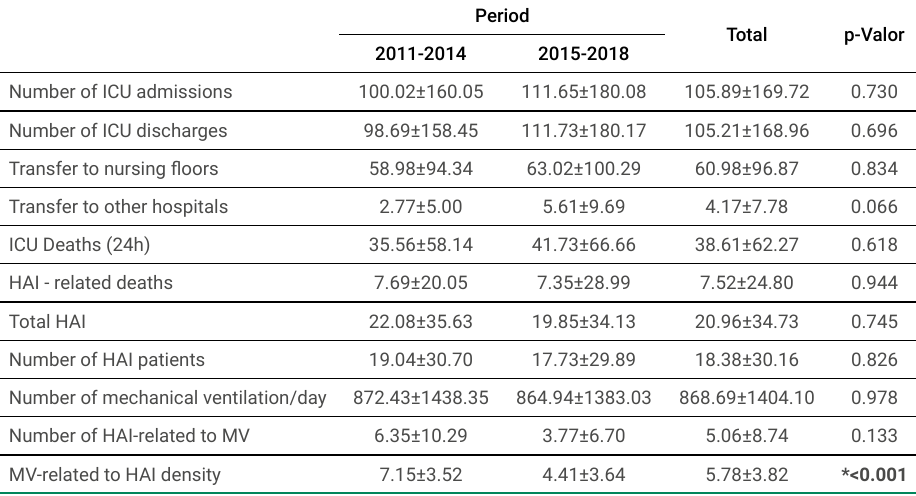
Table 1. General data from 2011-2014 and